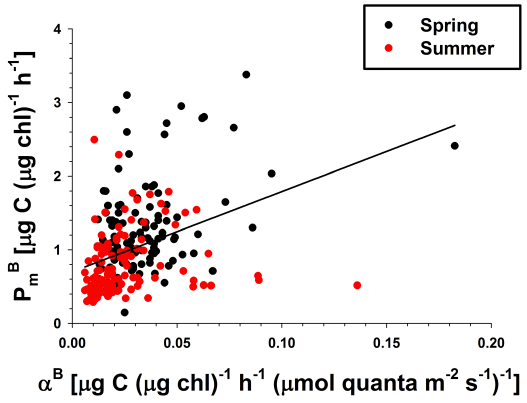
Figure 3. Relationship of α B (light-limited photosynthesis) and P B m (irradiance-saturated photosynthesis) in samples from the Ross Sea. Solid line is the linear regression ( P B m = 10.9 α B + 0.70; r 2 = 0.15; p